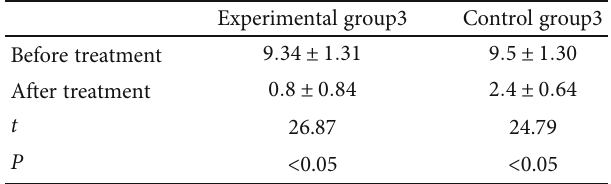
Table 7: Pain score after 4